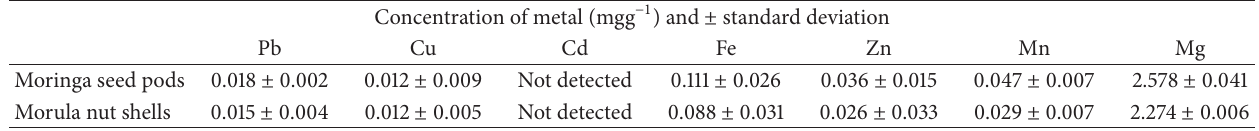
Table 1: Metal concentration (mgg −1 ) in Moringa seed pods and Morula nut shells. Concentration of metal (mgg −1 ) and ± standard deviation Moringa seed